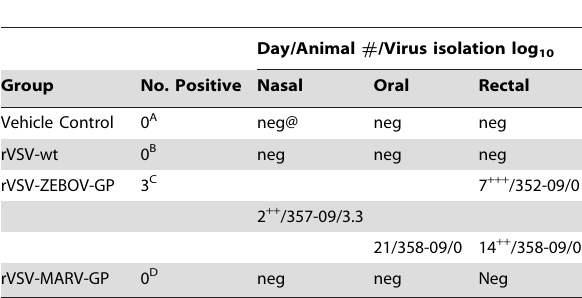
Table 3. Virus and Virus anti/genomes in animal swabs as measured by virus isolation and